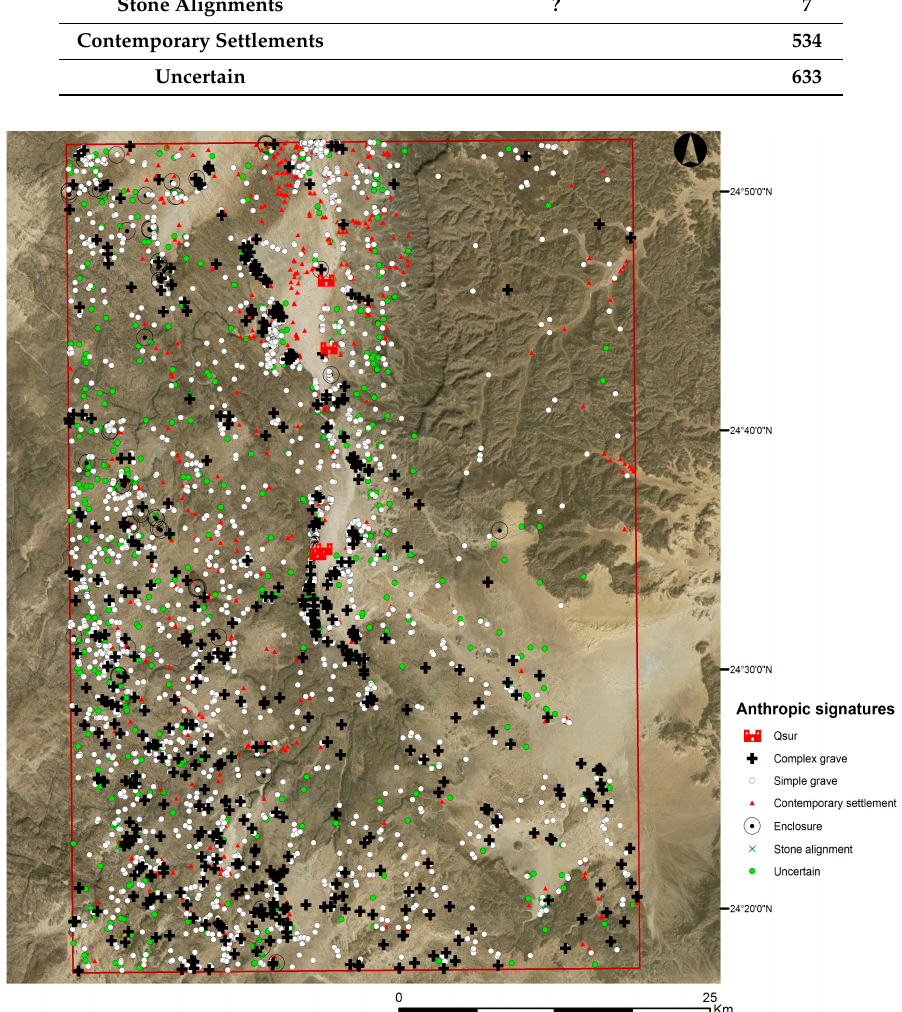
Figure 8. Map of anthropogenic features recorded in the study area (boxed) (satellite image courtesy of the DigitalGlobe Foundation). Table 5. Summary of different anthropogenic features identified in this study.